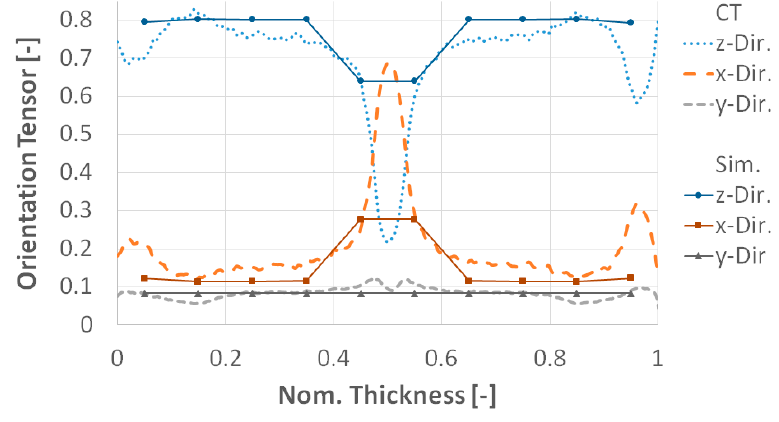
Figure 13. Fiber orientation tensors of the measured (CT) and calculated (Sim.) PA66 ‐ GF30 specimens.